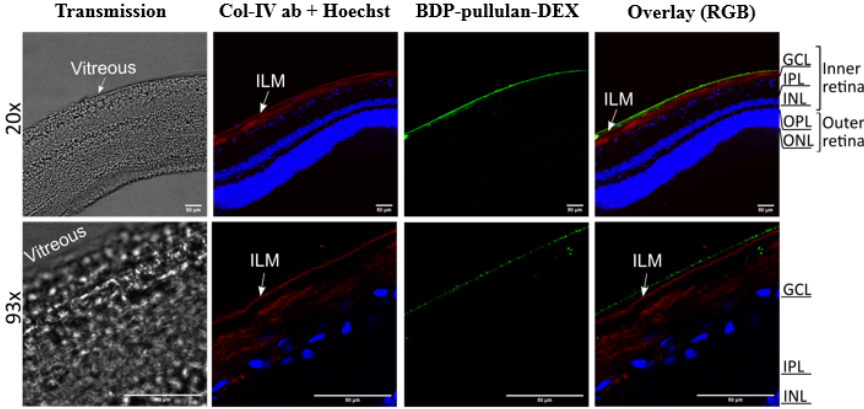
in GCL of the retina (Figure 13).